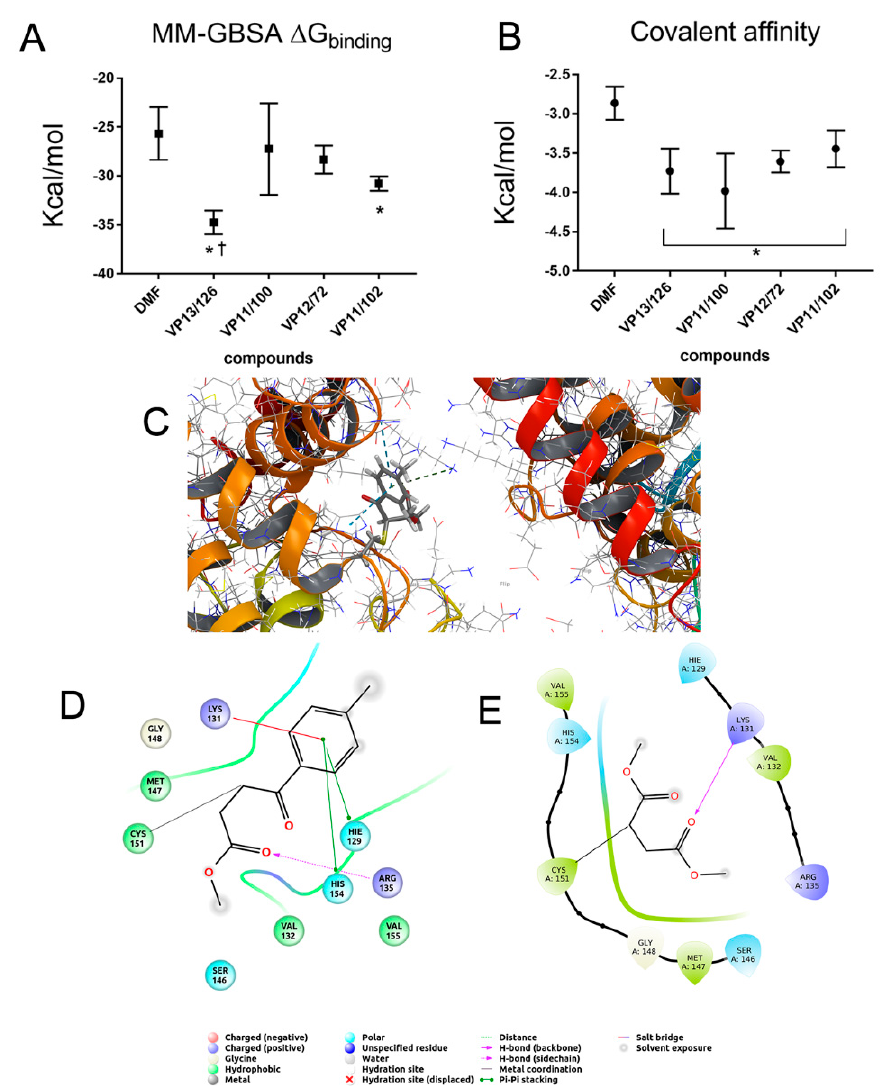
Figure 1. VP13/126 has the best (more negative) predicted Δ G binding energy for Keap1. ( A ) Binding free energy of compounds covalently docked to Keap, binding free energy was predicted through MM-GBSA calculation. ( B ) Covalent docking affinity as determined from covalent docking simulation. ( C ) 3D representation of VP13/126 pose bound covalently to Cys151 of Keap1 homodimer. ( D ) 2D representation of VP13/126 interactions with Keap1. ( E ) 2D representation of DMF interactions with Keap1. * p < 0.05 vs. DMF; † p < 0.05 vs. VP11/102 (compound 3); n = 4.